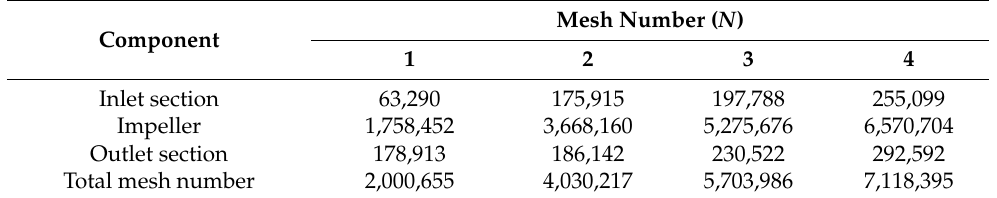
Figure 2. Meshes of HAMP .